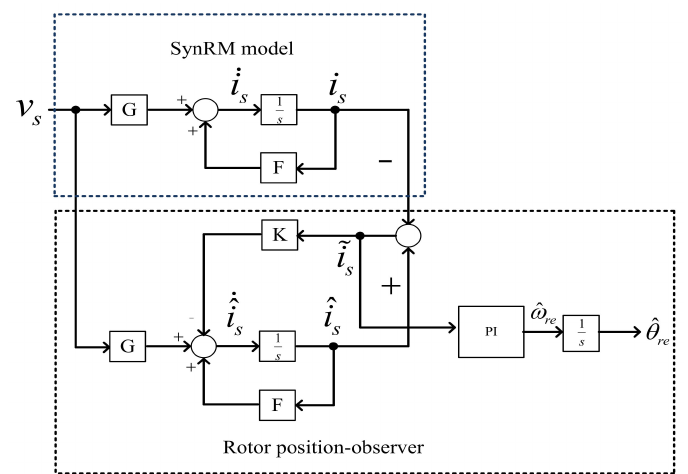
Figure 3. Proposed position